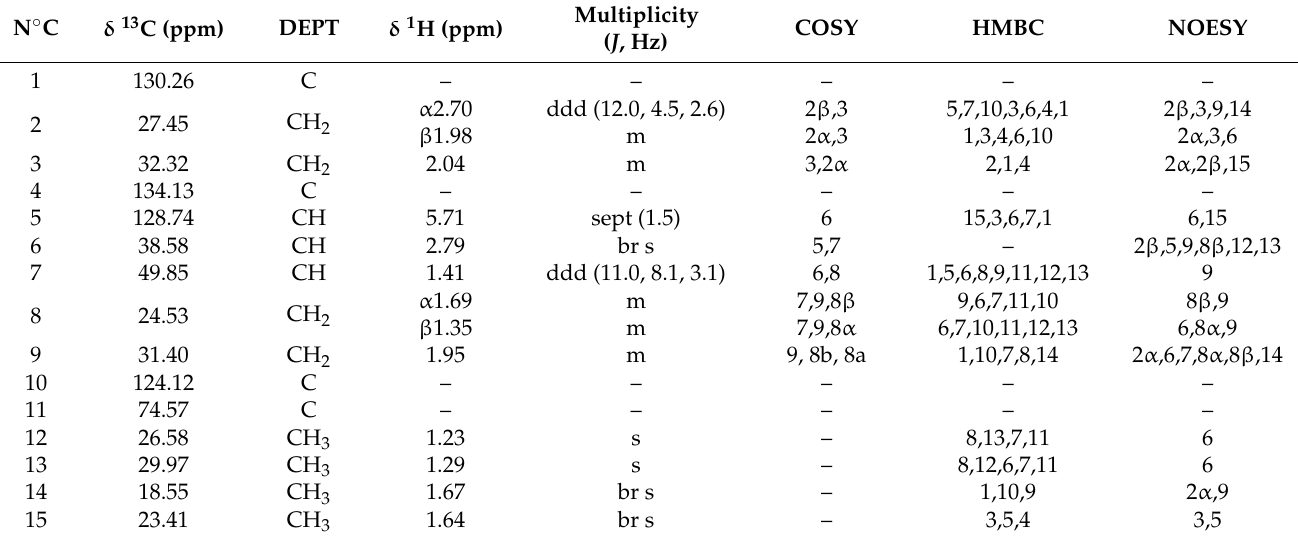
Table 2. 1D and 2D-NMR data of δ -cadinen-11-ol (compounds 96